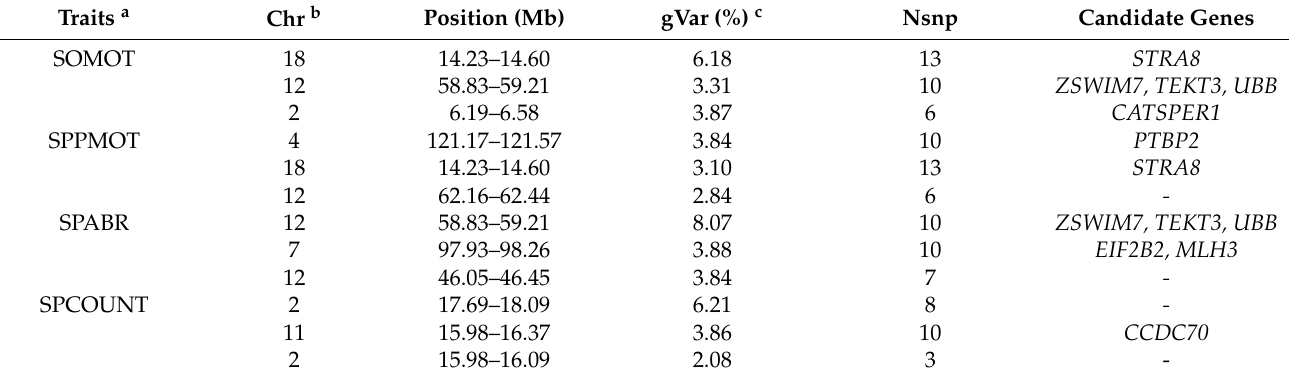
Table 3. Three most important QTL regions and candidate genes for semen traits of Duroc